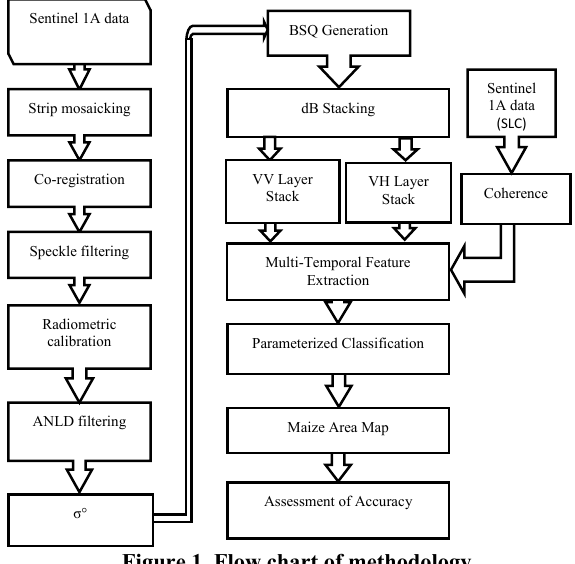
Figure 1. Flow chart of